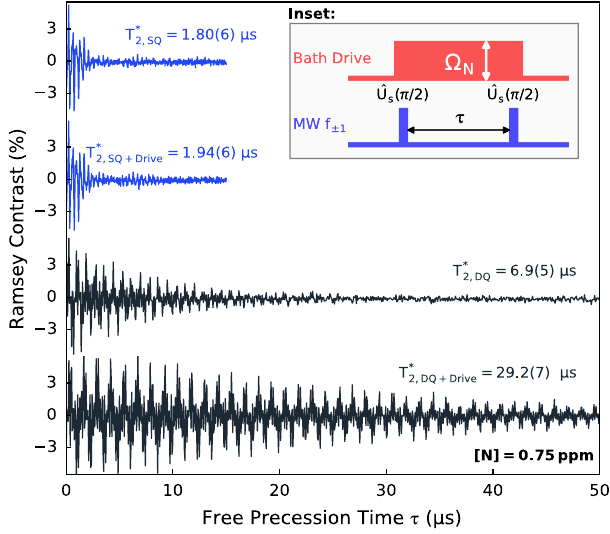
FIG. 3. NV Ramsey measurements for an intermediate nitrogen density sample (sample B, ½ N (cid:5) ¼ 0 . 75 ppm) at an applied bias magnetic field of B 0 ¼ 8 . 5 mT. Comparison of time-domain data and resulting fit values for the NV spin ensemble T (cid:1) 2 for the SQ coherence f 0 ; þ 1 g (blue, first from top); the SQ coherence with spin-bath drive (blue, second from top); the DQ coherence with no drive (black, third from top); and the DQ coherence with spin- bath drive (black, fourth from top). There is a 16 . 2 × improvement of T (cid:1) 2 with spin-bath drive when the DQ coherence is used for sensing compared to SQ with no drive. Inset: Two-tone NV Ramsey protocol with an applied spin-bath drive resonant with nitrogen